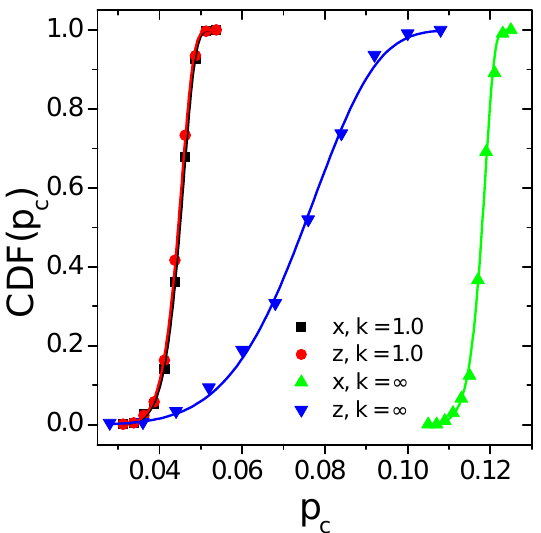
Figure 3. Empirical cumulative probability function for the percolation concentration in deformed and non-deformed composites (symbols), and Weibull cumulative probability distributions (CDFs) (5) (solid